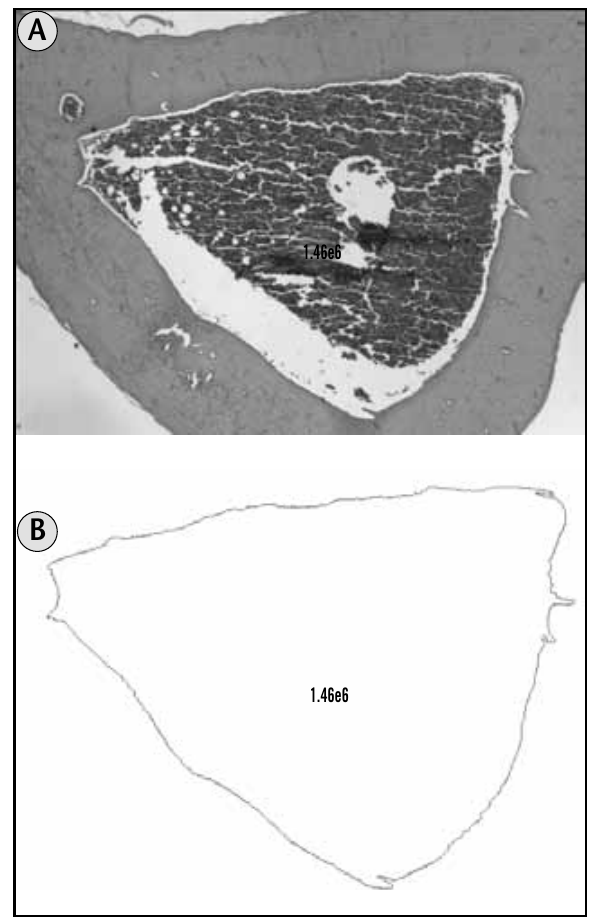
Figura 3 – Imagens da histomorfometria na área medular de tíbia. (a) Medição automática da área medular delineada (segmentada) sobre fundo transparente;